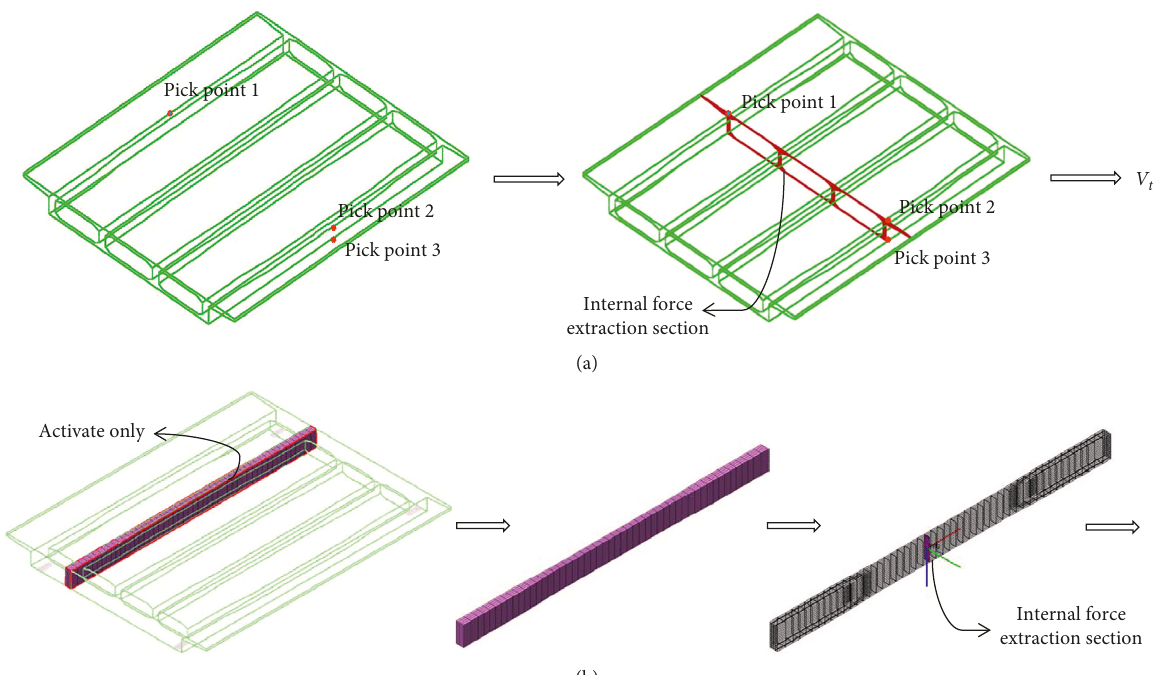
t in section. (b) Extraction of internal shear